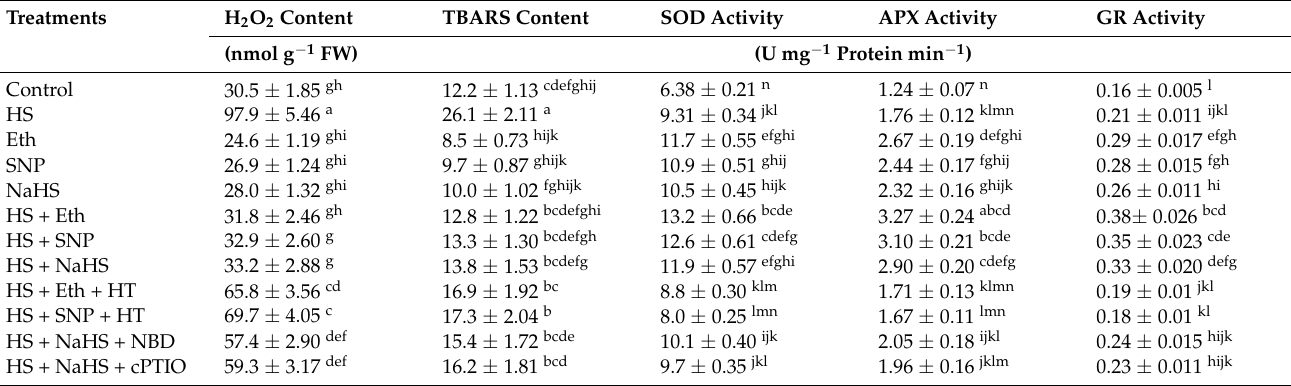
Table 5. Hydrogen peroxide (H 2 O 2 ), thiobarbituric acid reactive substances (TBARS) content, and activities of superoxide dismutase (SOD), ascorbate peroxidase (APX), and glutathione reductase (GR) in the leaves of rice ( Oryza sativa L.) cultivar Rasi after foliar treatment of plants with 200 µ L L − 1 ethephon (Eth), 100 µ M sodium nitroprusside (SNP) or 200 µ M sodium hydrosulfide (NaHS) grown with or without high temperature stress (HS; 40 ◦ C) or 100 µ M hypotaurine (HT), 100 µ M 2-4- carboxyphenyl-4,4,5,5-tetramethylimidazoline-1-oxyl-3-oxide (cPTIO), or 100 µ M norbornadiene (NBD) scavengers of hydrogen sulfide (H 2 S), nitric oxide (NO), and ethylene action inhibitors, respectively, with HS at 15 days after sowing. Data are presented as treatments mean ± SE ( n = 4). The values followed by the same letters did not differ significantly by LSD test at p < 0.05. FW, fresh